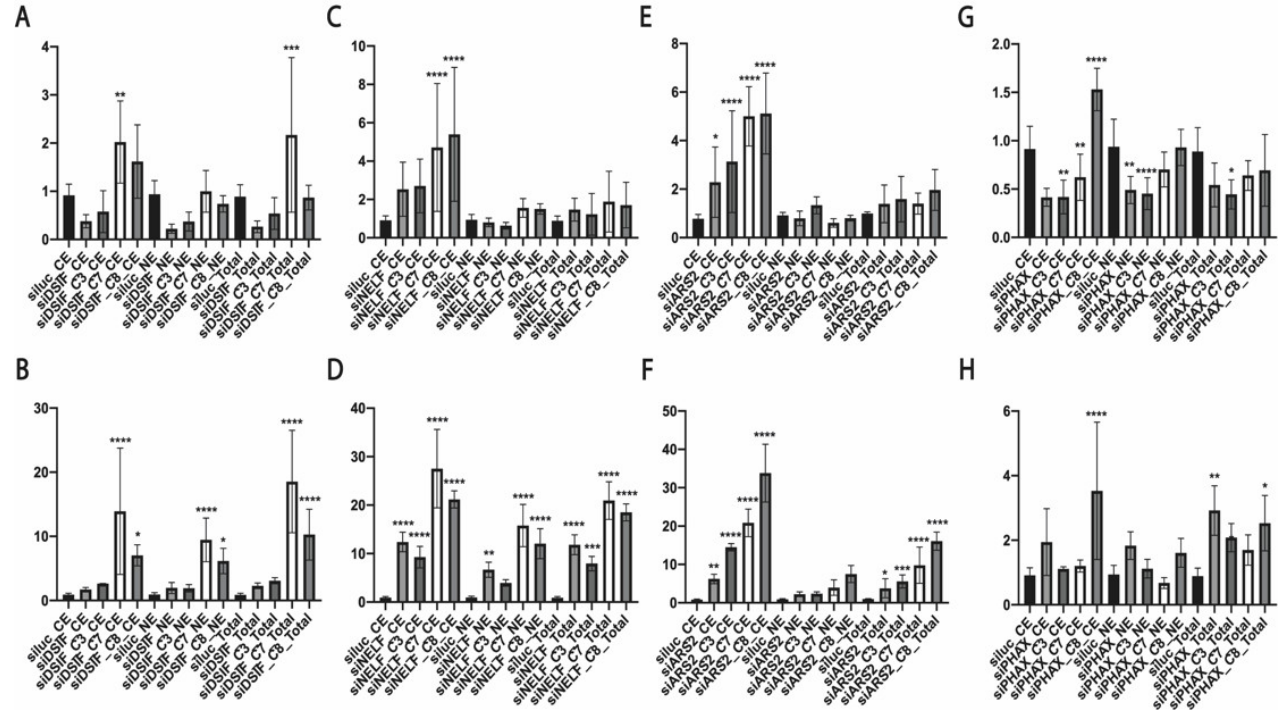
Figure 3. The role of RNA biogenesis factors in processing and transport of U2 snRNA. ( A , C , E , G ) Histograms demonstrating the relative amount of total (M+3′) U2 snRNA in the cytoplasmic (CE) and nuclear (NE) fractions and in the whole cell extract (Total) after the knockdown of the specified RNA biogenesis factor. ( B , D , F , H ) Histograms demonstrating the relative amount of premature (3′) U2 snRNA transcripts in the cytoplasmic (CE) and nuclear (NE) fractions and in the whole cell extract (Total) after the knockdown of the specified RNA biogenesis factor. siluc — control knockdown performed with siRNA specific to Firefly luciferase mRNA; siC3 — knockdown performed with siRNA specific to ZFC3H1; siC7 — knockdown performed with siRNA specific to ZCCHC7; siC8 — knockdown performed with siRNA specific to ZCCHC8. * p < 0.1, ** p < 0.01, *** p < 0.001, and **** p < 0.0001 by Dunett’s multiple comparison test.